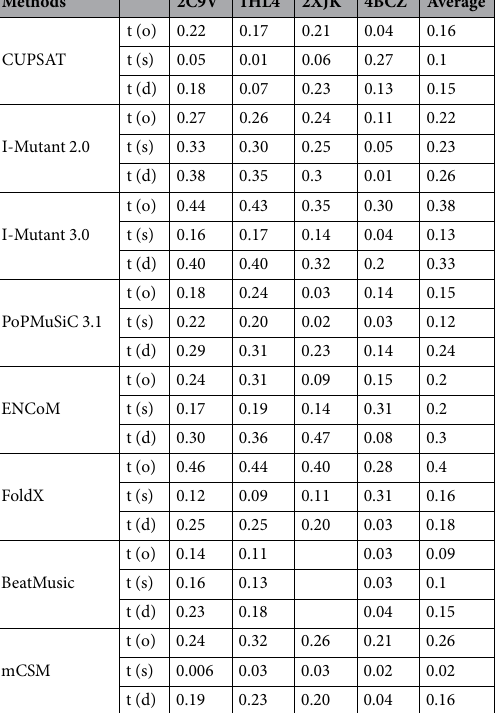
Table 2. Overall performance of stability calculators for SOD1 mutants in relation to patient’s data (Correlation coefficient, R